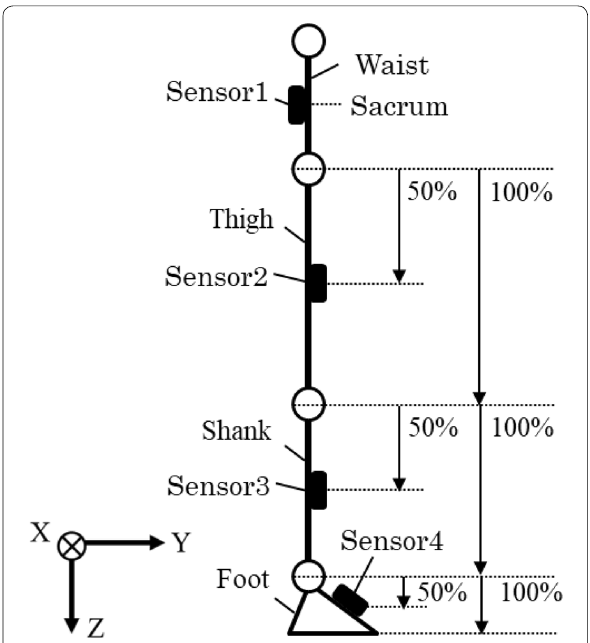
Fig. 2 Sensor positions and sensor coordinate